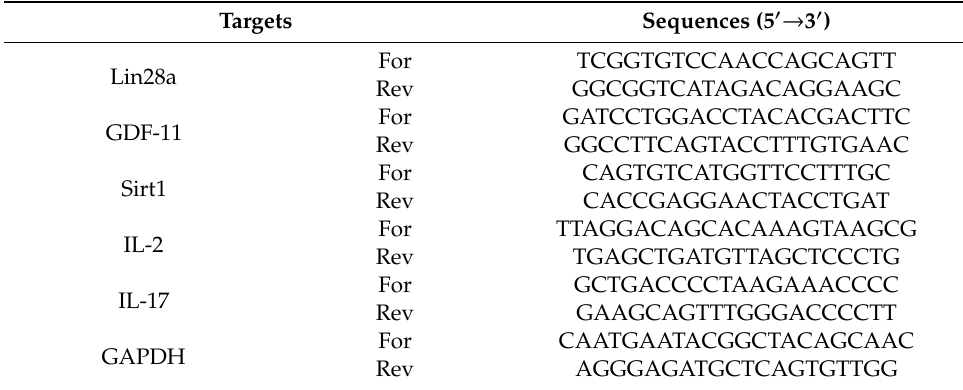
Table 2. Primer sequences used for quantitative real-time PCR in this